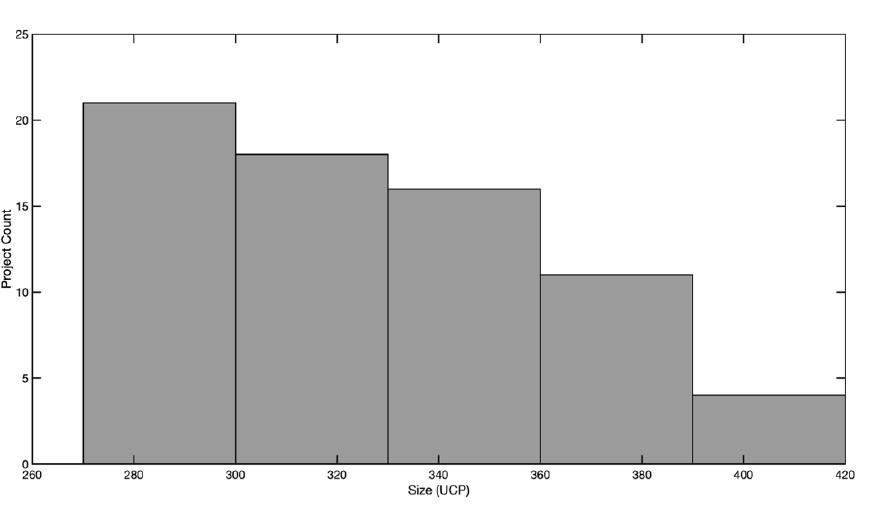
Figure 4. Project histogram (size in Use Case Points (UCP)). Table 1. Descriptive characteristics—dataset (DS).